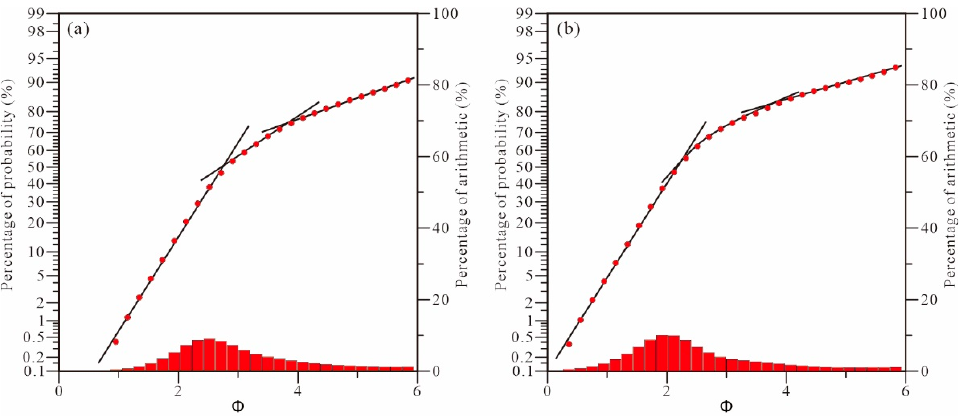
Figure 3. Grain-size curves of debris flow type. ( a ) Well QS7, 4100.30 m, one bouncing segment- Figure 3. Grain ‐ size curves of debris flow type. ( a ) Well QS7, 4100.30 m, one bouncing seg ‐ one suspension segment-one transitional zone pattern; ( b ) Well QS202, 4034.64 m, one bouncing ment ‐ one suspension segment ‐ one transitional zone pattern; ( b ) Well QS202, 4034.64 m, one segment-one suspension segment-one arc transitional zone bouncing segment ‐ one suspension segment ‐ one arc transitional zone pattern.